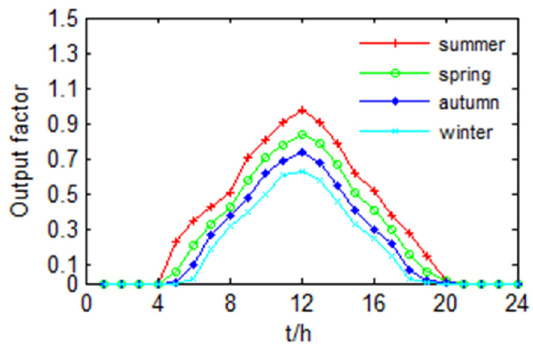
Figure 3. Timing characteristics of photovoltaic output in different seasons.